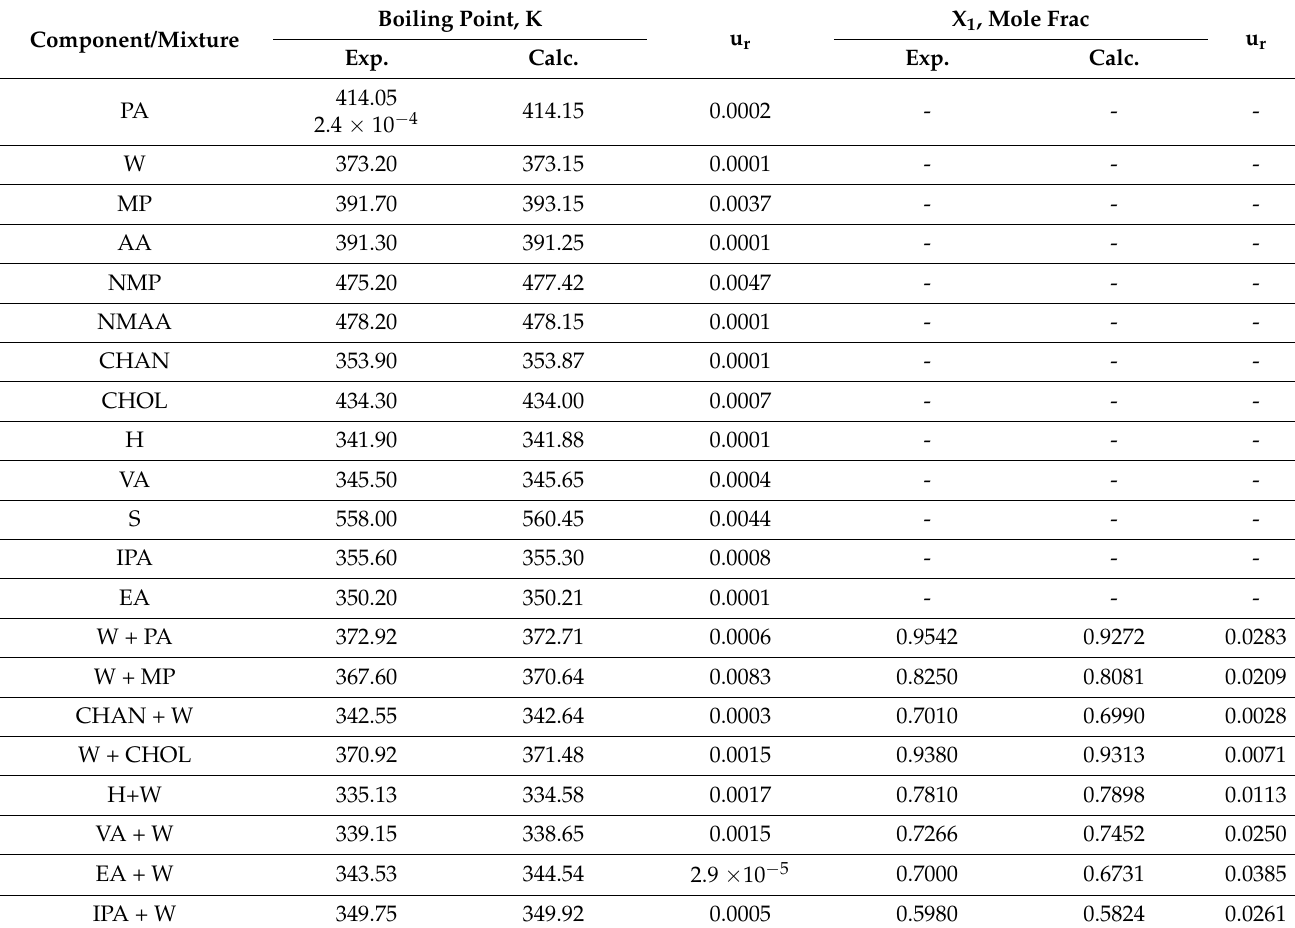
Table 2. The experimental and calculated boiling point and azeotropic composition (at 101.3 kPa) [28–41].